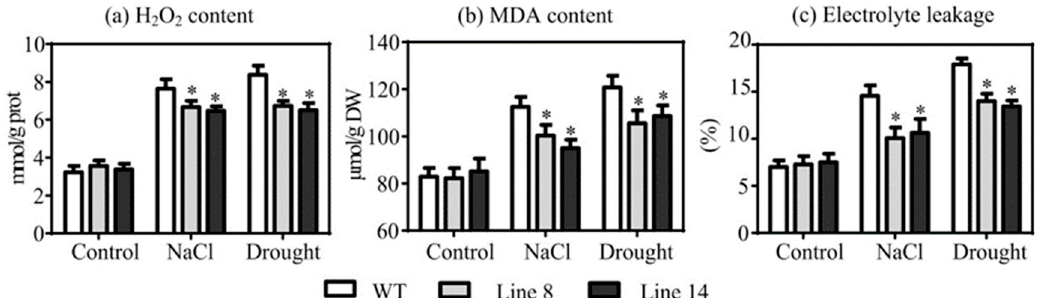
Figure 5. Comparison of hydrogen peroxide (H 2 O 2 ) ( a ), malondialdehyde (MDA) content ( b ), and electrolyte leakage ( c ) of WT and two overexpressing lines under the control, 300 mm NaCl, and drought stress conditions. Values are means ± SD (standard deviation). Asterisk indicates a significant difference at the p < 0.05 significance level, as determined with SPSS v. 19.0.